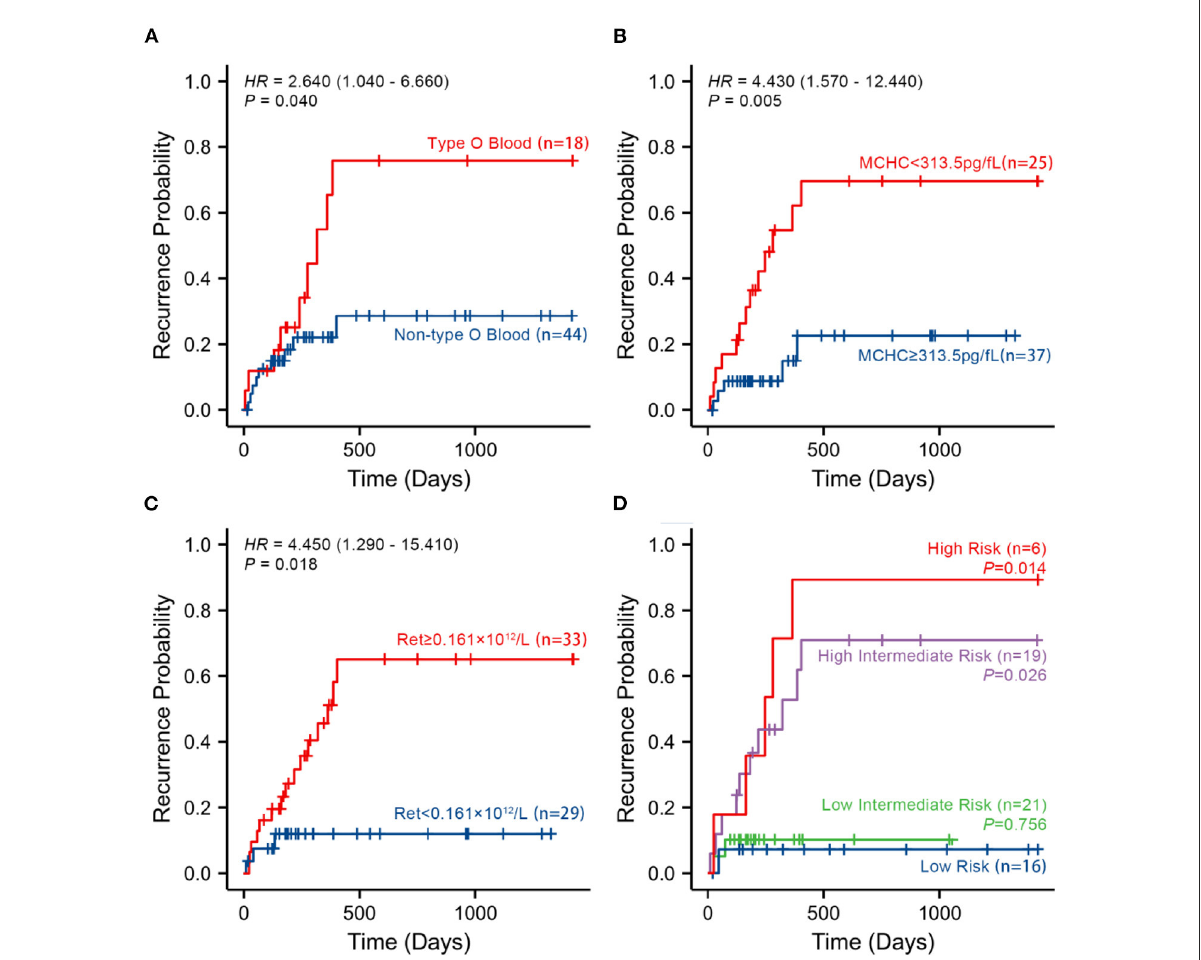
FIGURE3 Kaplan–Meier survival curves according to the three risk indicators and the multivariate logistic regression model analysis in 62 patients with no recurrence event. (A–C) The probability of recurrence in patients with type O blood, a lower MCHC, and a higher Ret, respectively, using Kaplan–Meier survival curves. (D) The probability of recurrence in patients in different risk groups. MCHC, mean corpuscular hemoglobin concentration; Ret, reticulocyte count; High-Risk, patients with all risk indicators at baseline; Intermediate-High-Risk, patients with two of three risk indicators at baseline; Intermediate-Low-Risk, patients with only one of three risk indicators at baseline; Low-Risk, patients with no risk indicator at